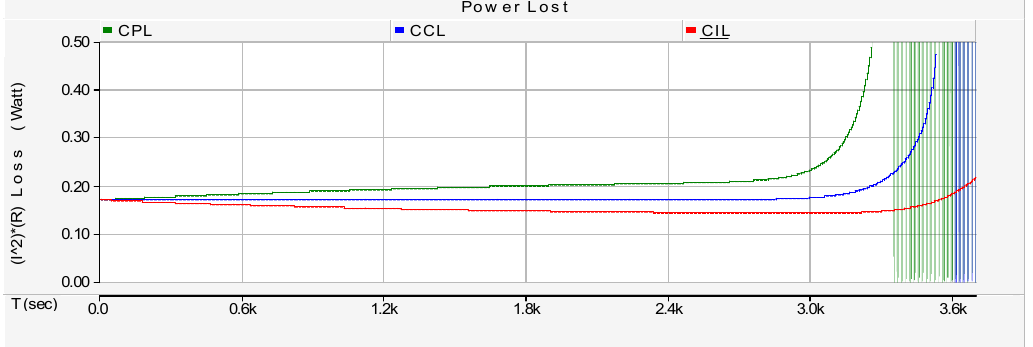
Figure 14. Instantaneous I 2 R l oss curves.